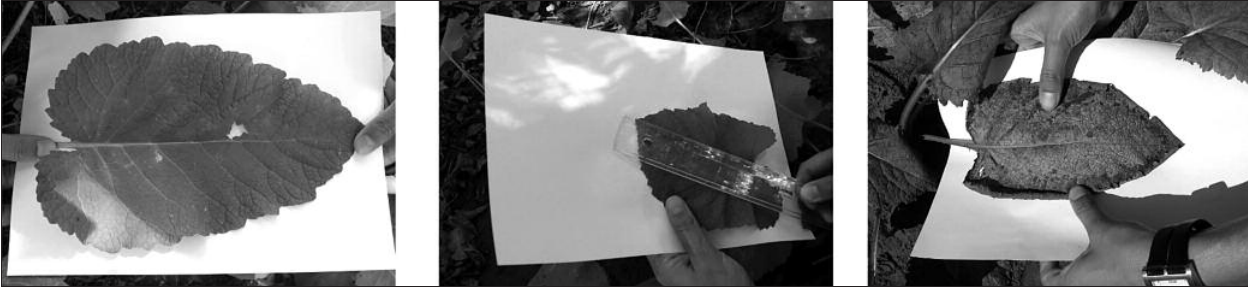
Figure 2. Leaf size of the Telekia speciosa (Schreb.)Baumg at semi shadow (left), at shadow (middle) and at sunny (right) habitat.